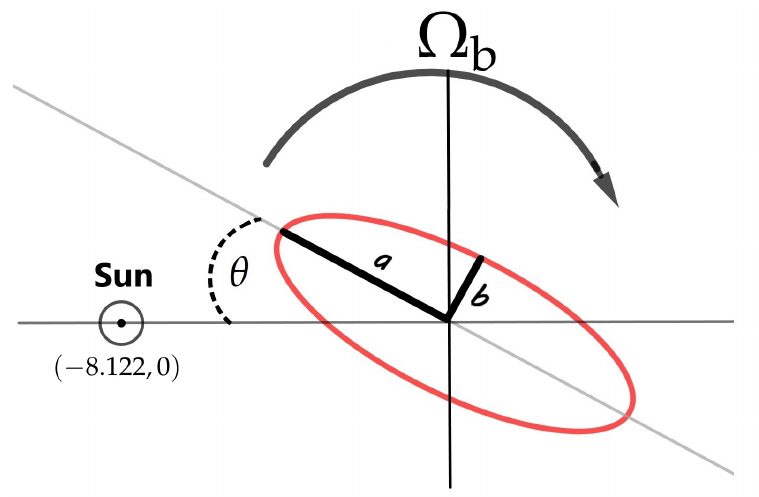
Figure 2. Schematic representation of the position of the Milky Way bar relative to the Sun. The angle θ between the Sun and the bar is 28 ◦ . The bar has an angular rotation velocity Ω b and rotates clockwise, so Ω b has a negative sign.